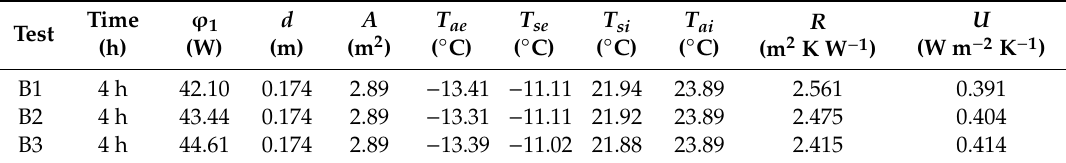
Table 5. Thermal transmittance and thermal resistance of sandwich panel filled with short-cut woodchips insulation under steady-state conditions.